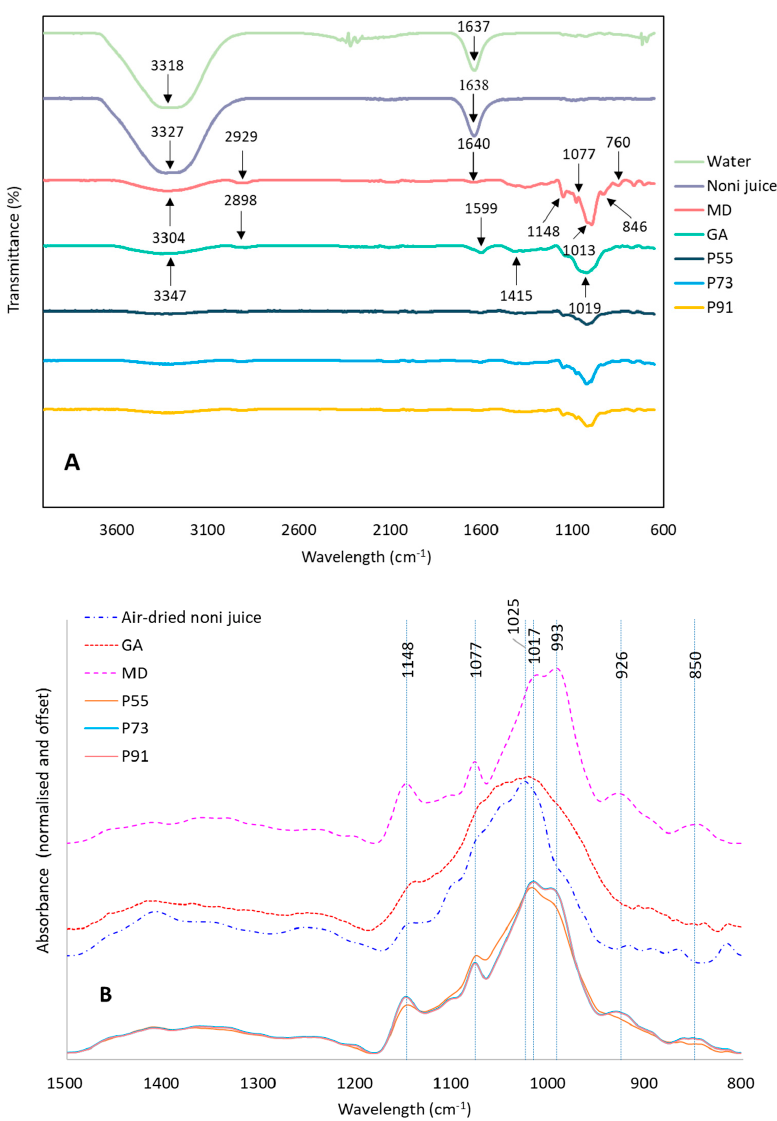
Figure 4. Attenuated Total Reflection-Fourier Transform Infrared Spectroscopy (ATR-FTIR) spectra of ( A ) Transmission spectra of water, pure noni juice, individual carrier (MD and GA) and spray-dried noni juice powders. ( B ) Absorption spectra of air-dried noni juice sample, individual carrier (MD and GA) and spray-dried noni juice powders. MD: maltodextrin; GA: gum acacia; P55, P73 and P91: powders produced using maltodextrin and gum acacia as carriers with the blended ratios of 5:5, 7:3 and